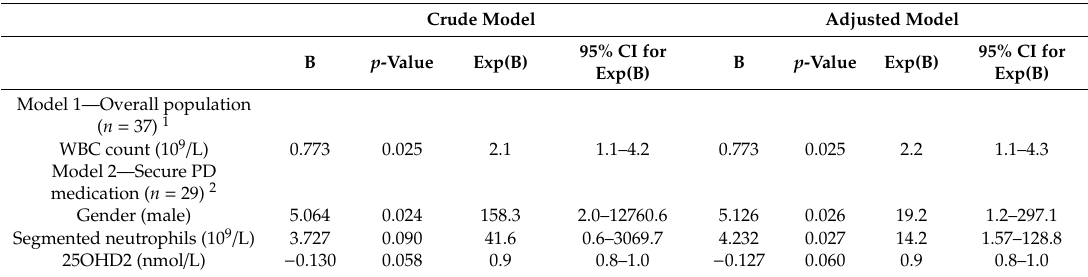
Table 4. Final reduced logistic regression models for the overall population ( n = 37) and patients with secure PD medication ( n =